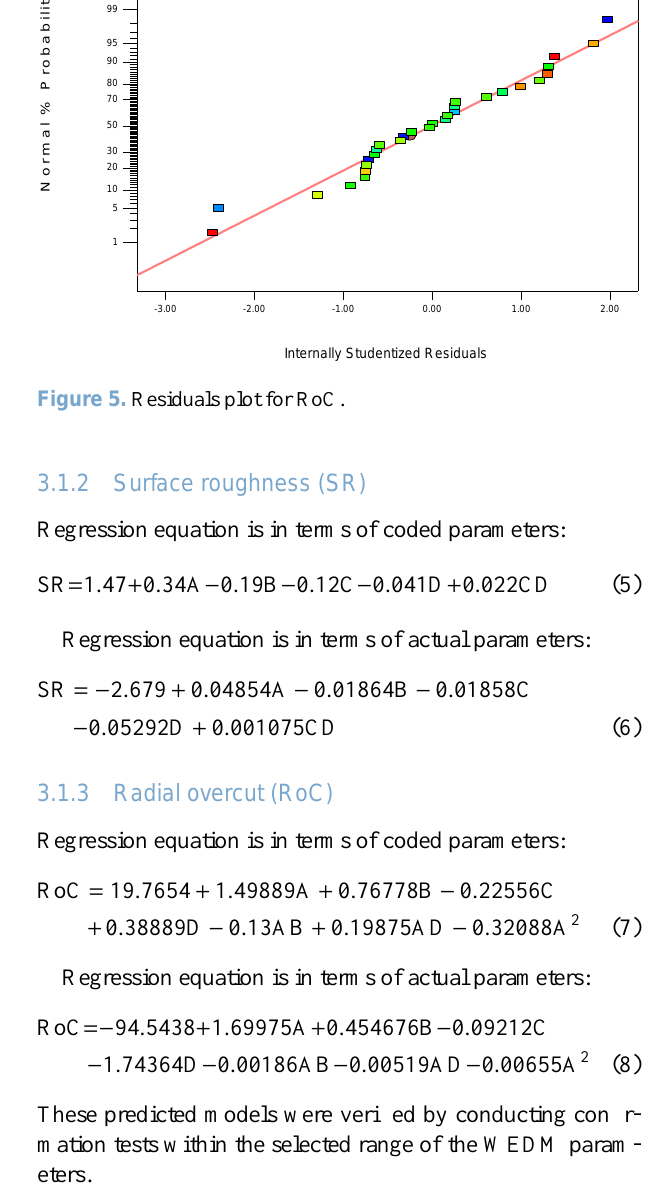
Figure 5 Residuals plot for RoC